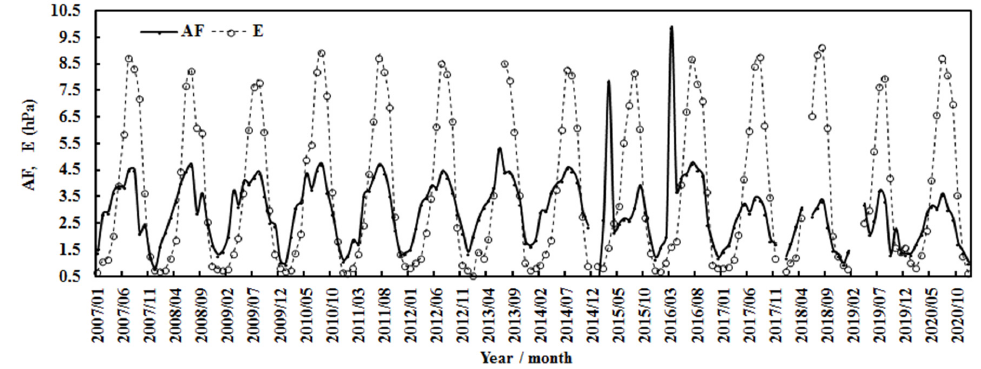
Figure 5. Monthly water-vapor pressure (E) and attenuation (AF) at the Qomolangma site during